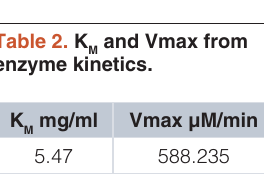
and V obtained from the double reciprocal plot M max